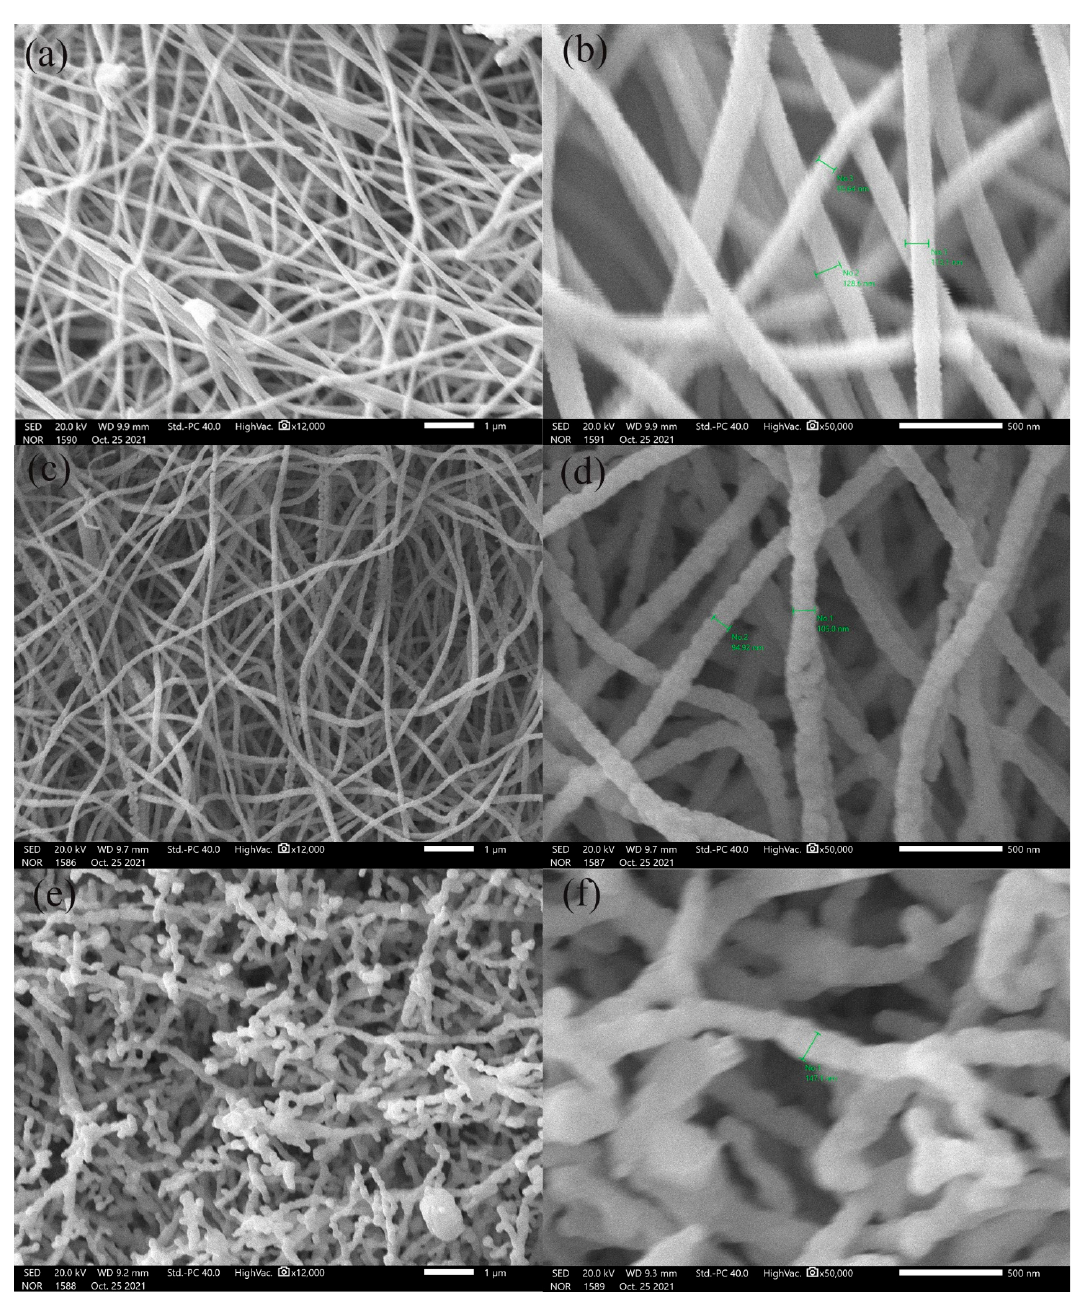
Figure 2. SEM images of SFMO fibers after electrospinning and calcination, obtained with different calcination temperatures of ( a , b ) 600 °C, ( c , d ) 800 °C, and ( e , f ) 1000 °C. Before testing a symmetrical cell and carrying electrochemical characterization, the chemical compatibility between SFMO and LSGM needs to be verified. Figure 3 shows the XRD patterns of the prepared SFM nanofibers, the LSGM powder, and the SFMO– LSGM mixed bar after sintering at 1300 °C for 6 h, respectively. Firstly, it can be seen that the nanofibers display a clearly defined perovskite structure with a symmetrical cubic phase, which is found to crystallize in the cubic space group Fm3m. Then, the